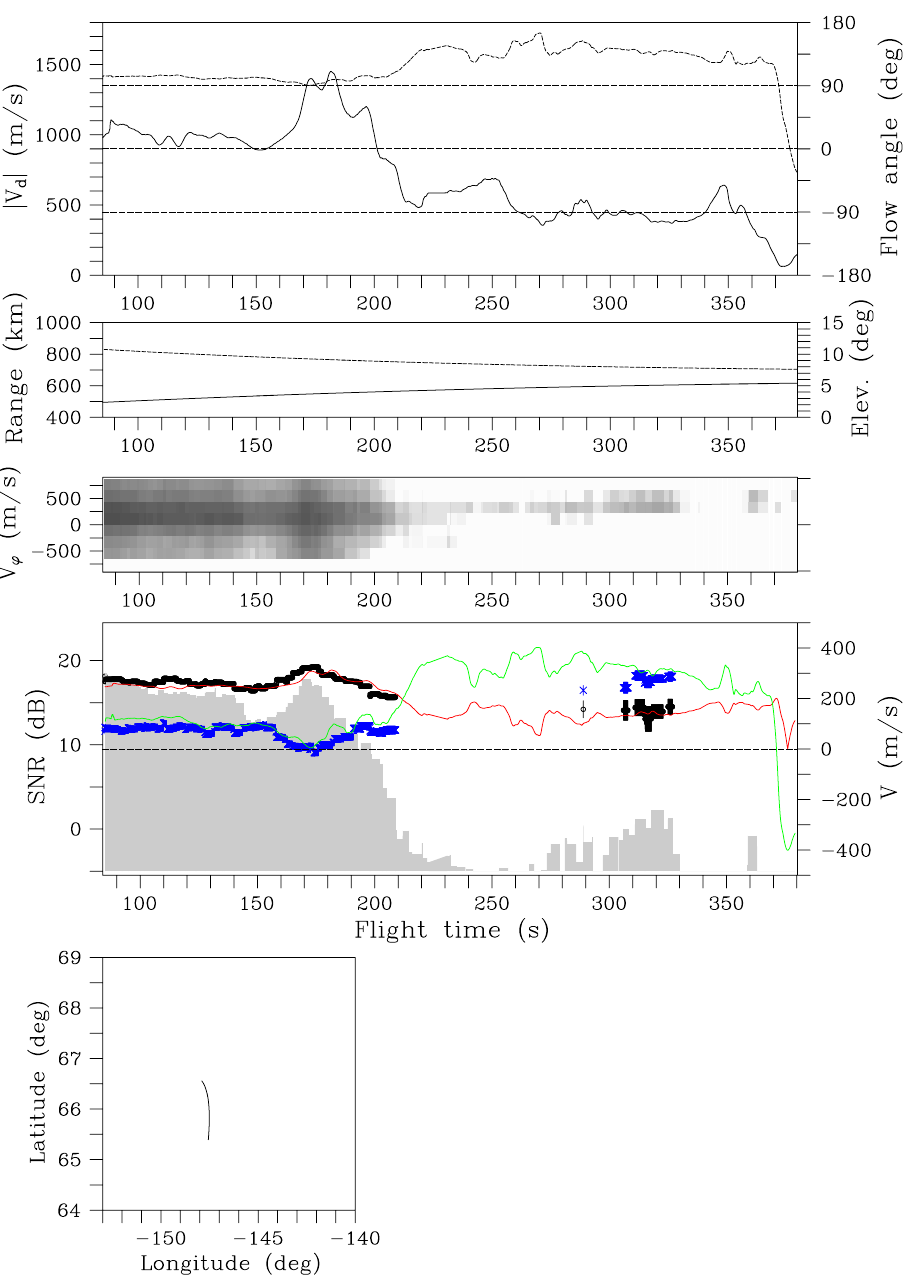
Fig. 6. Same as previous figure, only for JOULE I rocket flight 21.131 on 27 March 2003. Here, T0=12:12:01UT. Data were processed in the same manner as the JOULE II